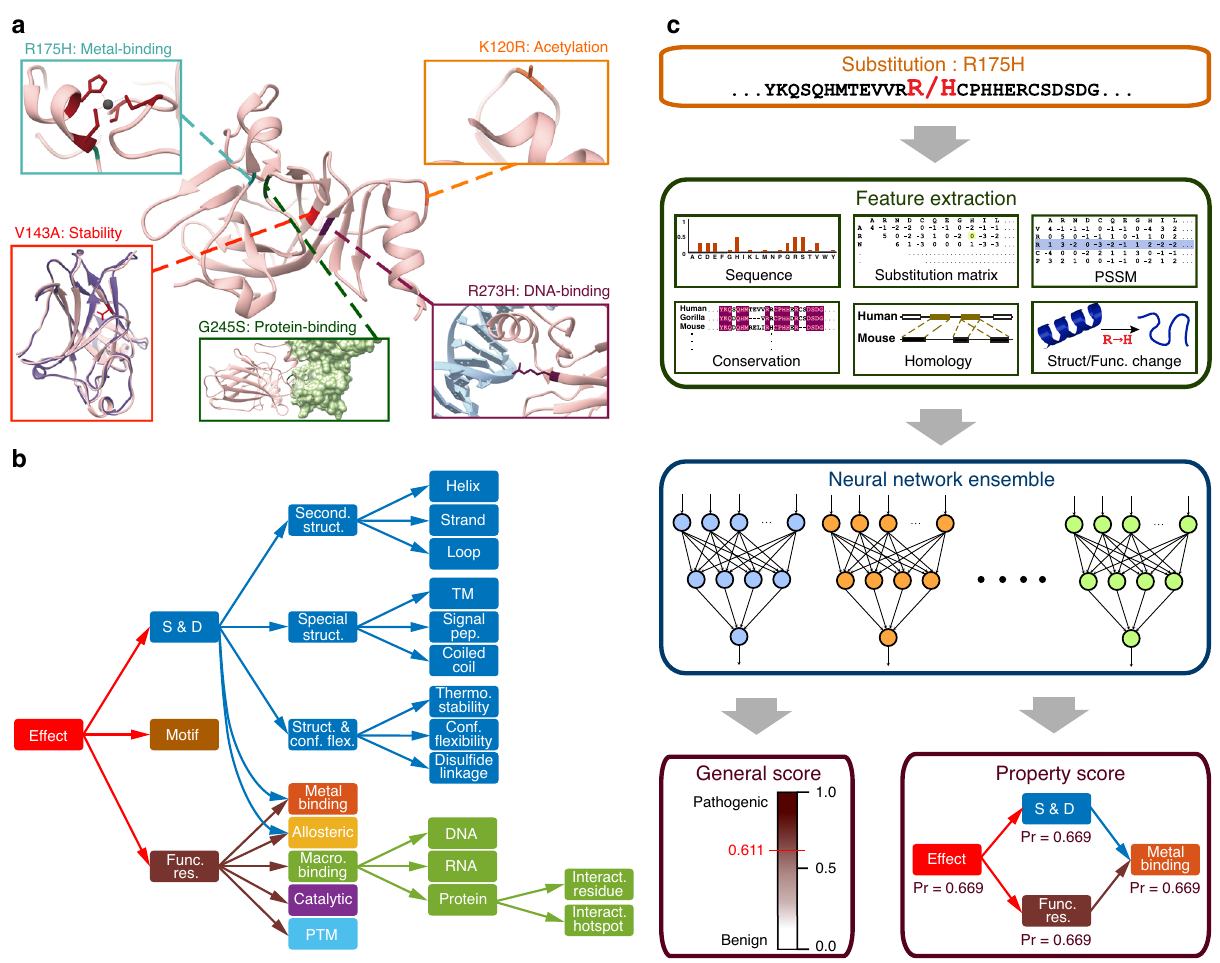
Fig. 1 MutPred2 and the molecular consequences of amino acid substitutions. a The human tumor suppressor p53 as an illustration of the numerous possible effects of amino acid substitutions on protein structure and function. Protein Data Bank IDs for the structures shown are 1TUP, 1YCS, 2J1W, and 2YBG. b The ontology constructed in this study to organize the possible structural and functional effects of amino acid substitutions. It is con fi ned to the